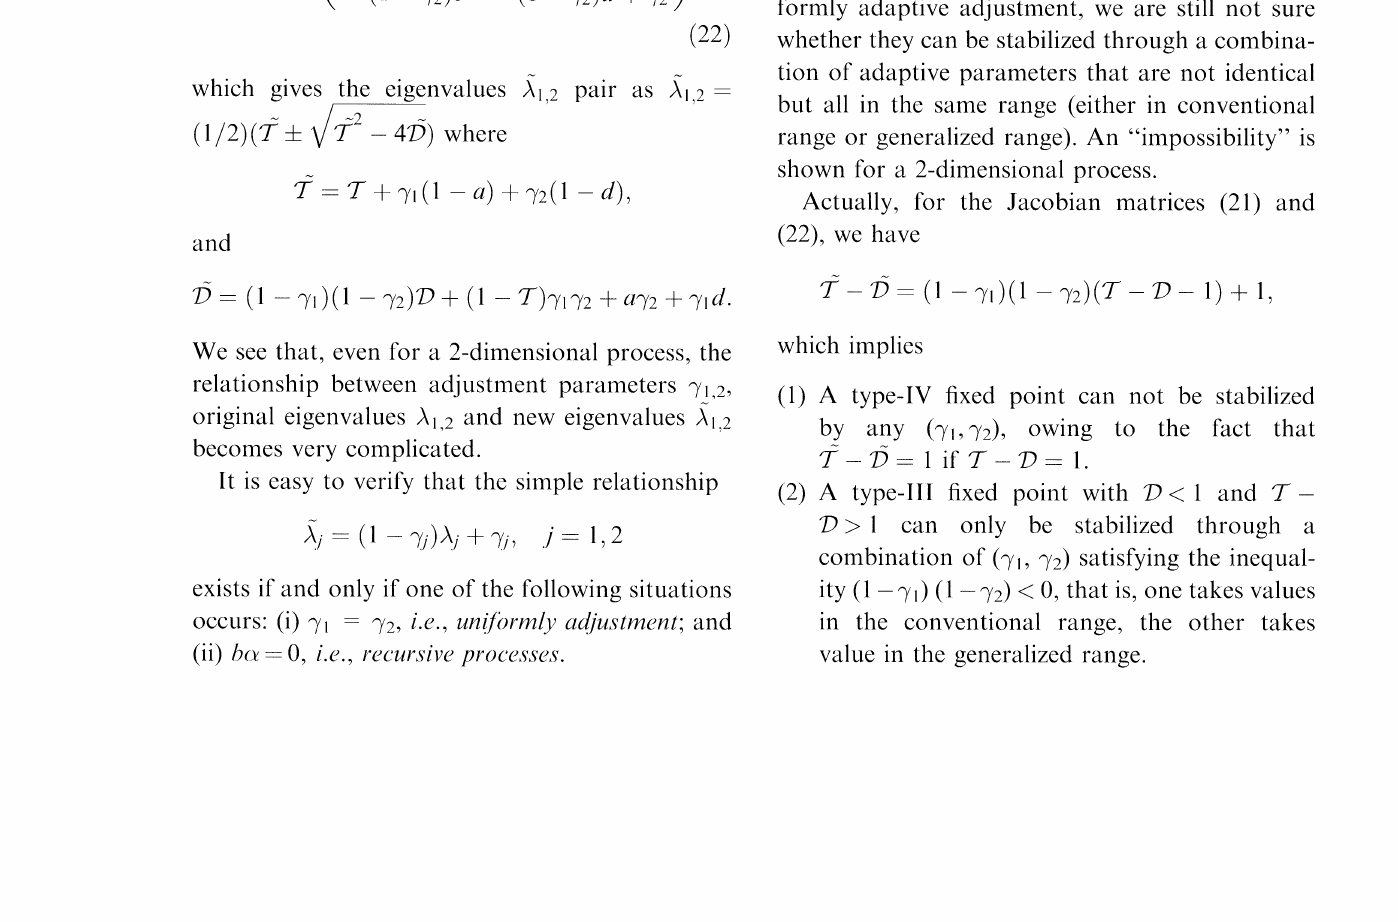
FIGURE 6 Distribution offixed